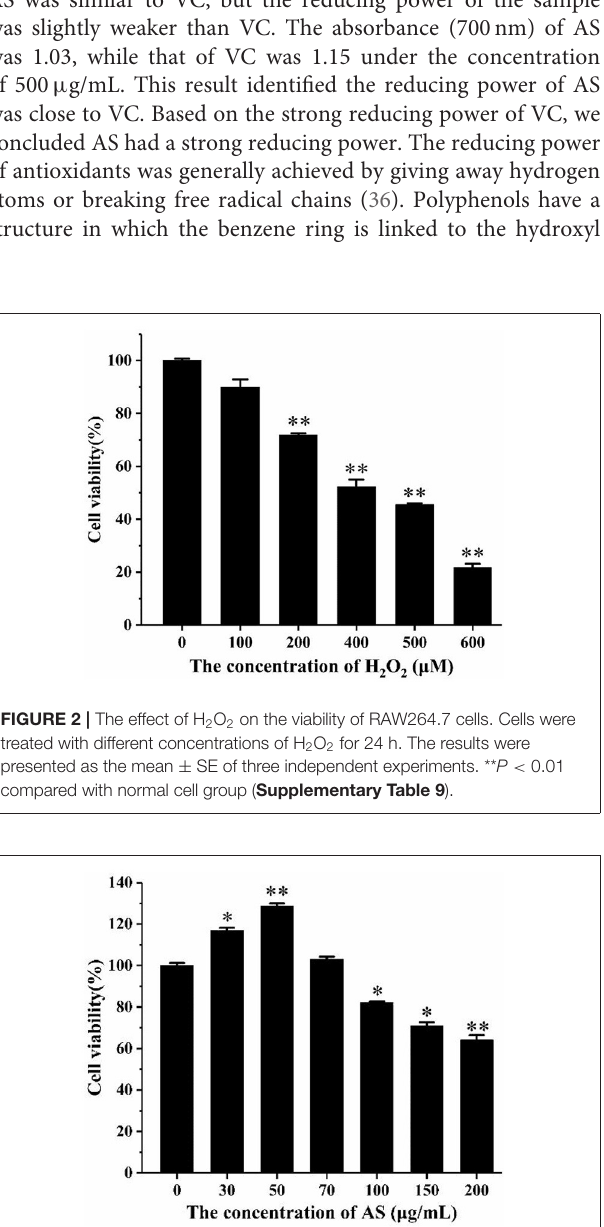
FIGURE 3 | The effect of AS on the viability of RAW264.7 cells. Cells were treated with different concentrations of AS for 24h. The results were presented as the mean ± SE of three independent experiments. * P < 0.05 and ** P < 0.01 compared with the normal cell group ( Supplementary Table 8 ).